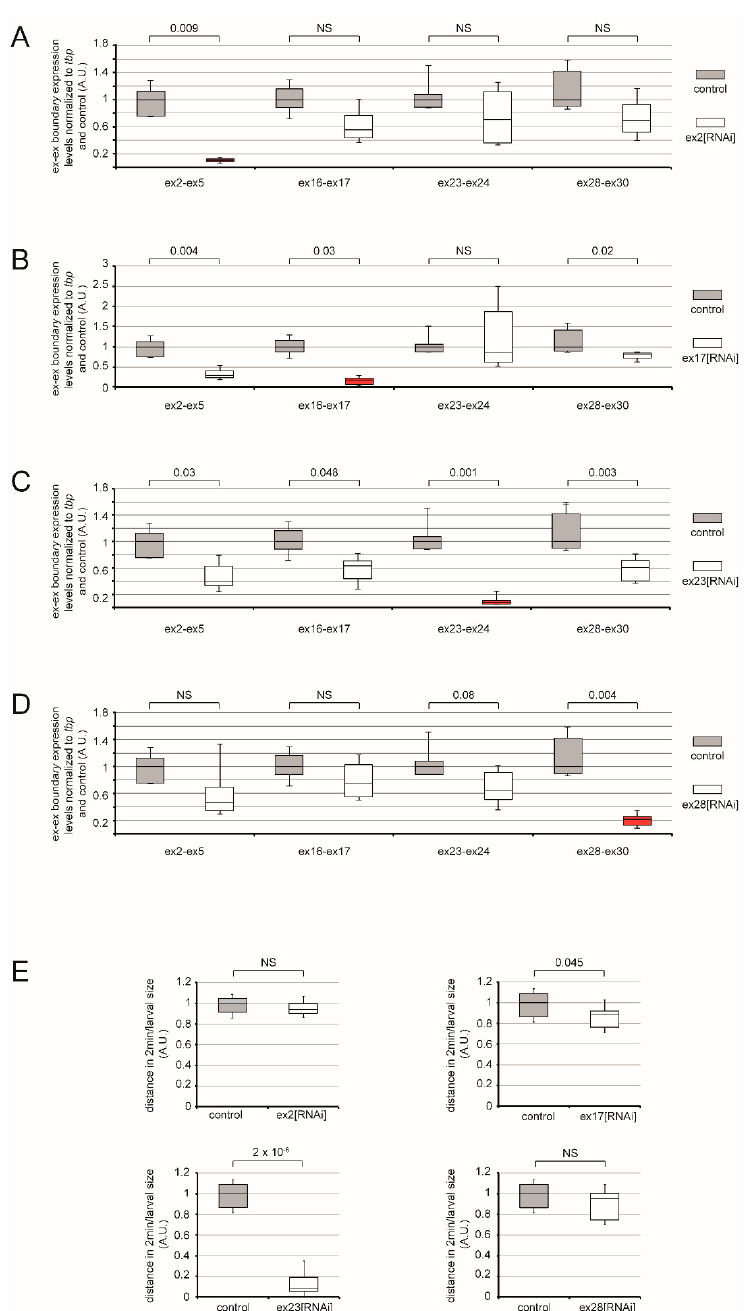
Figure 2. Msp300 isoforms differentially contribute to larval locomotion. ( A – D ) Box plot representation of muscular Msp300[RNAi] efficiency and impact on non-targeted isoform groups by RT-qPCR analysis. The expression level of